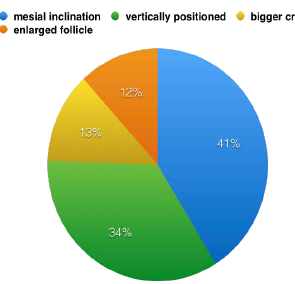
Figure 2. Characteristics of the non-erupted molars.